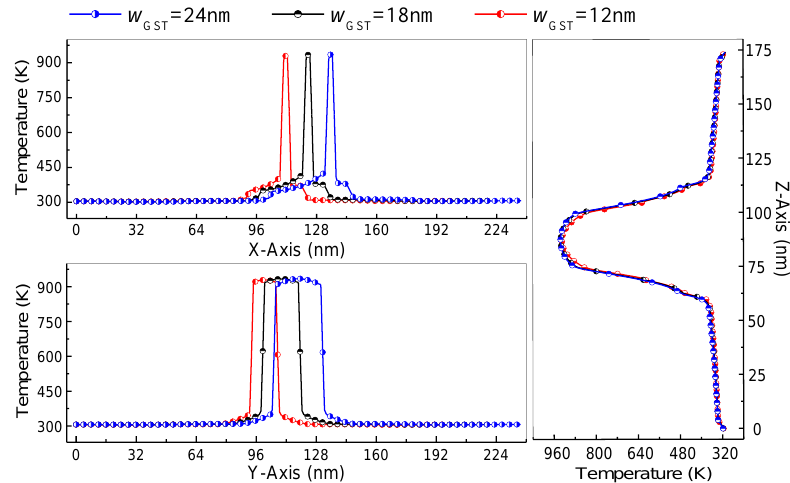
Figure 14. Temperature distributions on lines through the center point of the GST structure of the activated cell along axis with changing w GST values.